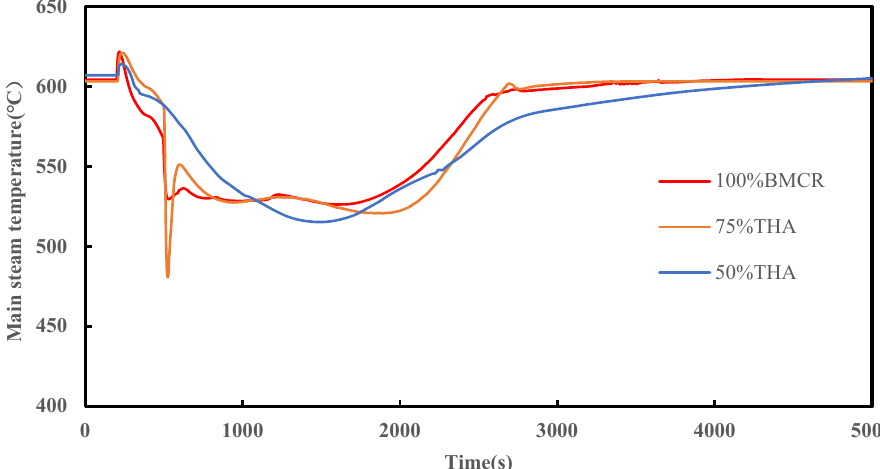
Figure 11. Response of main steam temperature during BT at different conditions.